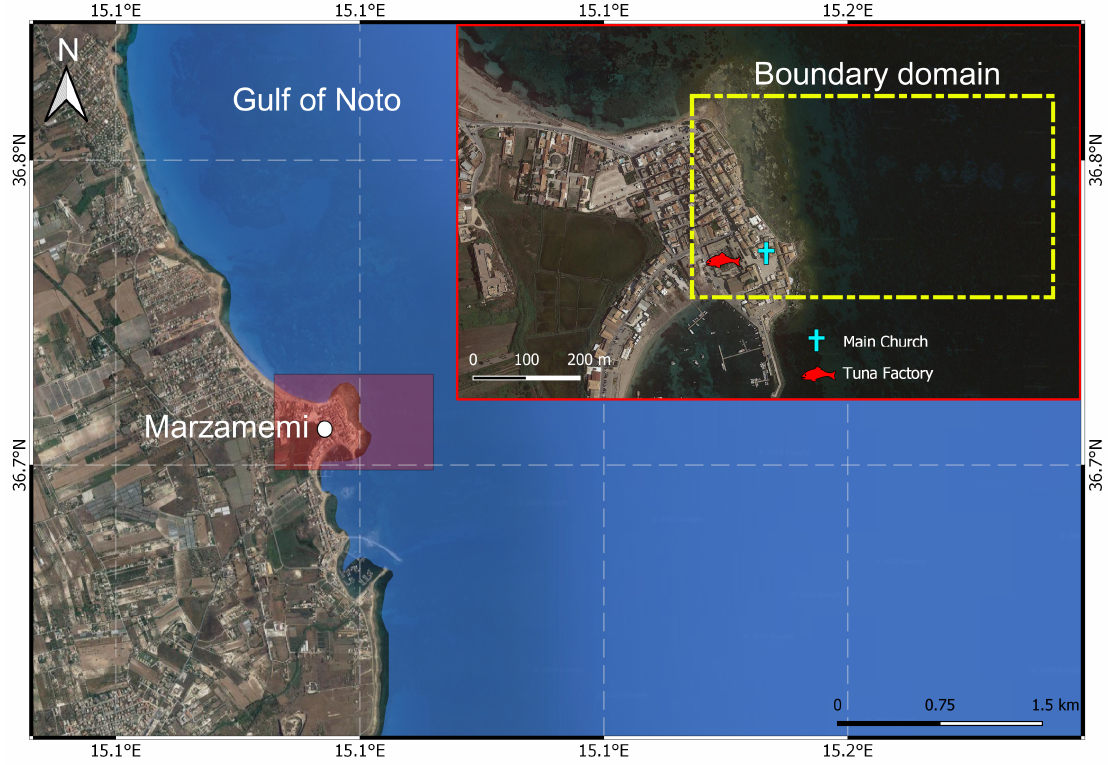
Figure 2. The case study area. The red rectangle shows the Marzamemi promontory, the yellow dash-dot line highlights the boundaries of the numerical